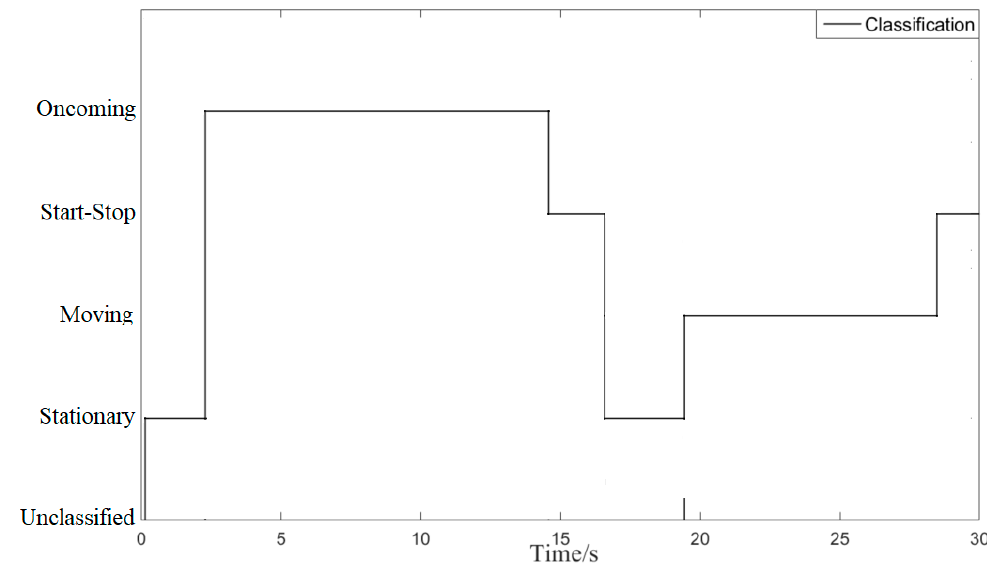
Figure 11. The movement state transfer of the target-vehicle.